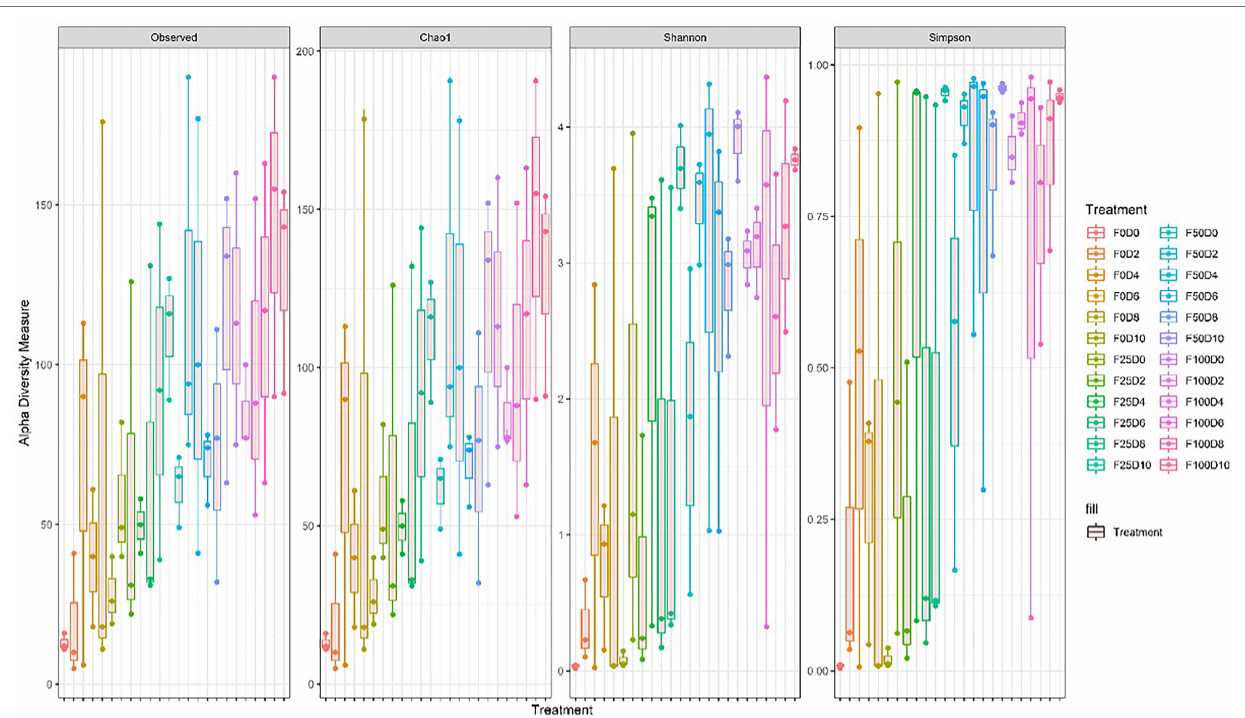
FIGURE 2 | Alpha diversity for all treatments estimated from the observed richness, Chao1 index, Shannon index and Simpson index.